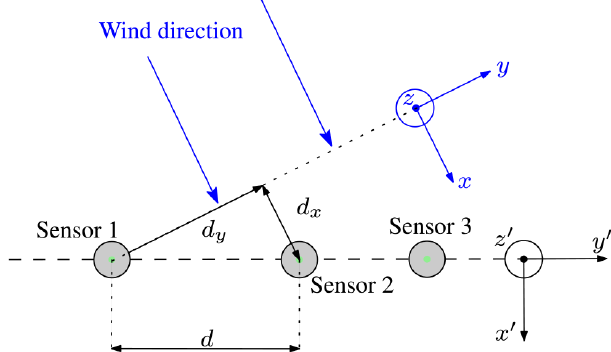
Figure 7. Sketch of a typical configuration of three anemometers (sensors 1, 2 and 3) mounted at the same height along a linear ar- ray of masts to study the lateral co-coherence of wind. This sketch is used for illustrative purpose only and does not reflect the instru- mentation of the COTUR